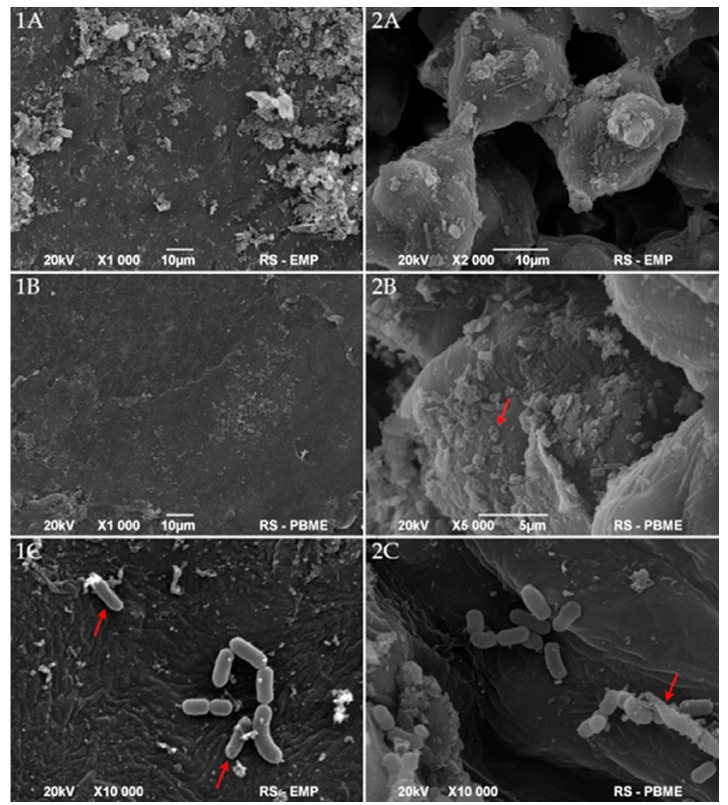
Figure 3. Scanning electron micrographs of coats ( 1 ) and hila ( 2 ) of mung bean inoculated with pathogens ( A ( 1 , 2 )) and after then disinfected with D2 method ( B ( 1 , 2 )) or DP2 method ( C ( 1 , 2 )); arrows indicate destroyed ( 2 ( B , C )) or damaged ( 1C ) cells.